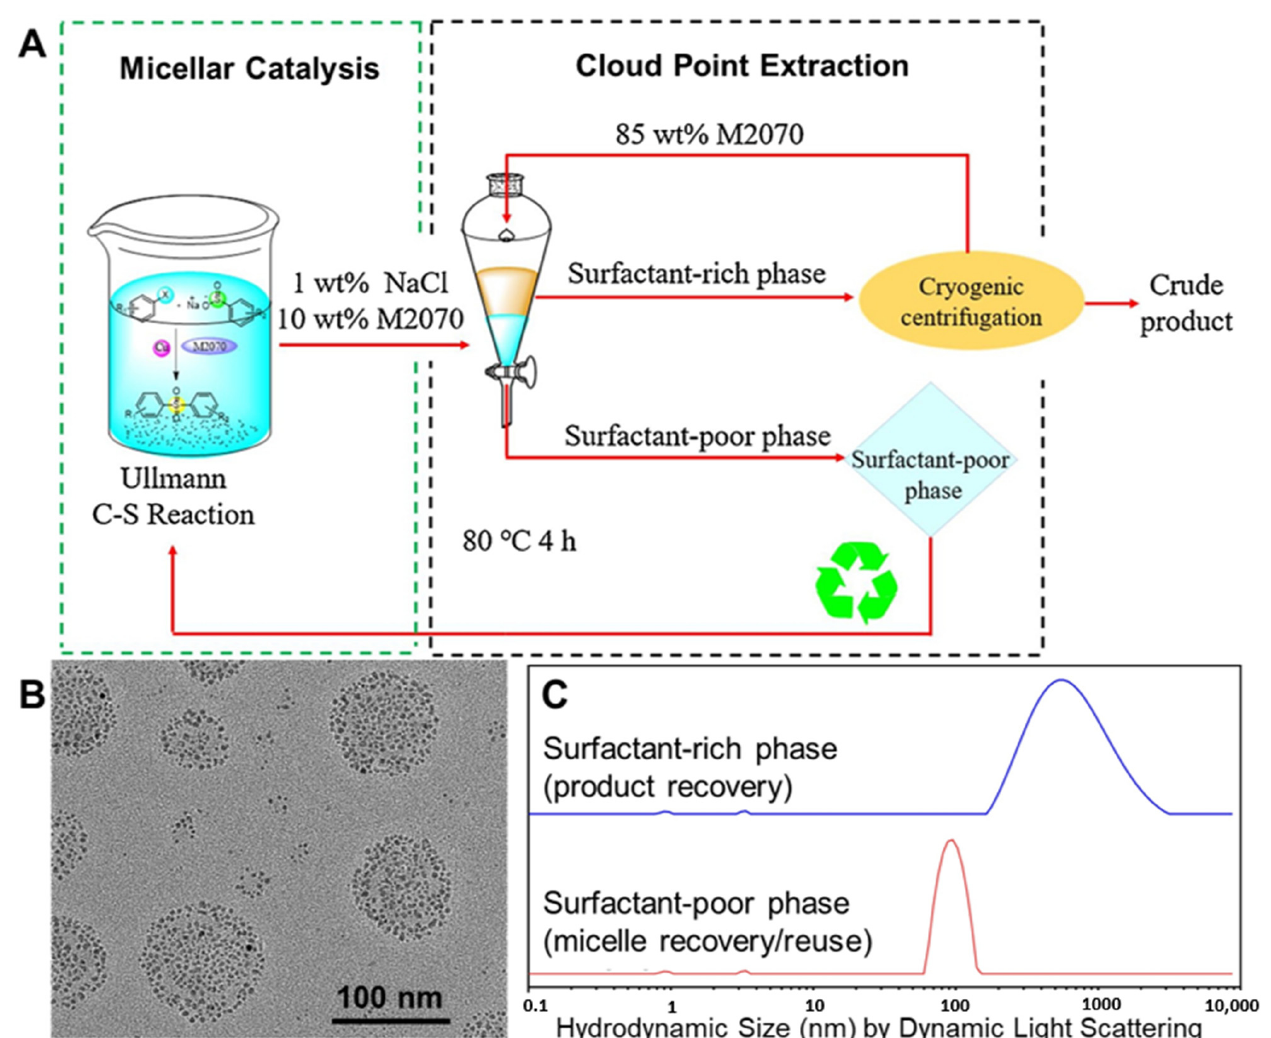
Figure 15. ( A ) Overview of a tandem process of micellar catalysis cloud-point extraction following copper-catalyzed Ullmann C-S coupling reactions in water using the nonionic surfactant amine- terminated polyether M2070. Following the reaction, the mixture was heated to above the apparent cloud point of M2070, resulting in phase separation. One “surfactant-rich” phase contained the product. The other “surfactant-poor” phase contained the surfactant-only micelles that could be re- used. ( B ) TEM image of the M2070 aggregates at room temperature. Spherical aggregates ca. 4 nm in diameter further aggregated into large spheres ca. 110 nm in diameter. ( C ) Dynamic light scatter- ing of the two phases after cloud-point extraction. The average micelle size was 93 nm in the surfac- tant-poor phase and 600 nm in the surfactant-rich phase containing product. Ultimately, the product was recovered as a solid via high-speed freezing centrifugation. Adapted with permission from [169].